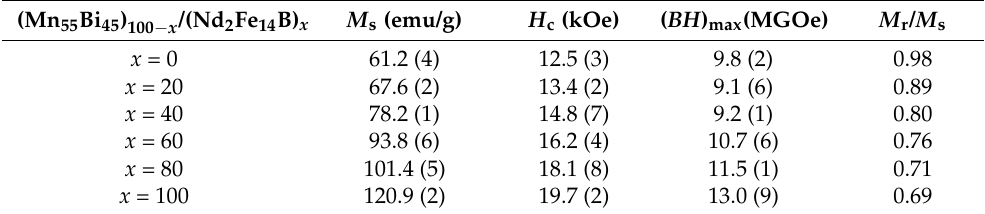
Figure 4. The variation curves of saturation magnetization ( M s ), coercivity ( H c ), and maximum energy product ( BH ) max of the bulk (Mn 55 Bi 45 ) 100 − x /(Nd 2 Fe 14 B) x ( x = 0, 20, 40, 60, 80, and 100) hybrid magnetic alloys with the increase of Nd 2 Fe 14 B content. Table 2. The room temperature magnetic properties of the bulk (Mn 55 Bi 45 ) 100 − x /(Nd 2 Fe 14 B) x hybrid magnetic